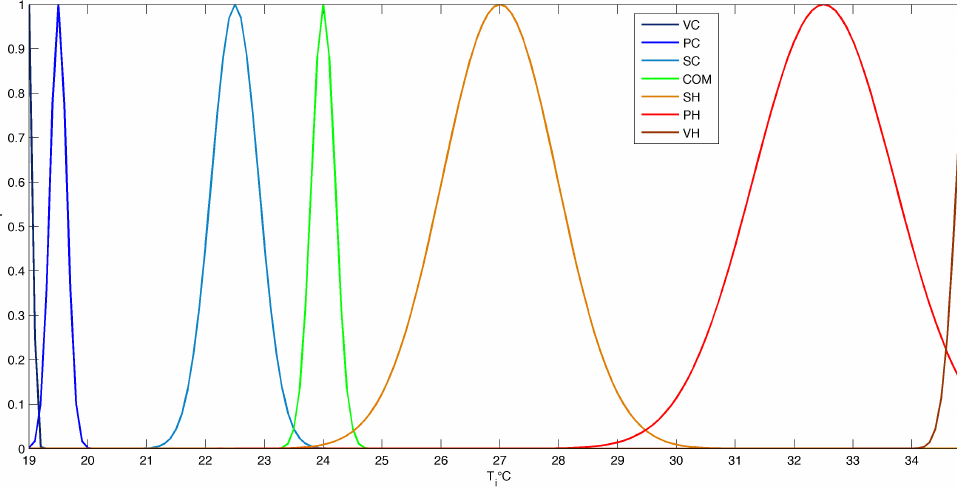
Figure 10. Adjusted membership functions for T